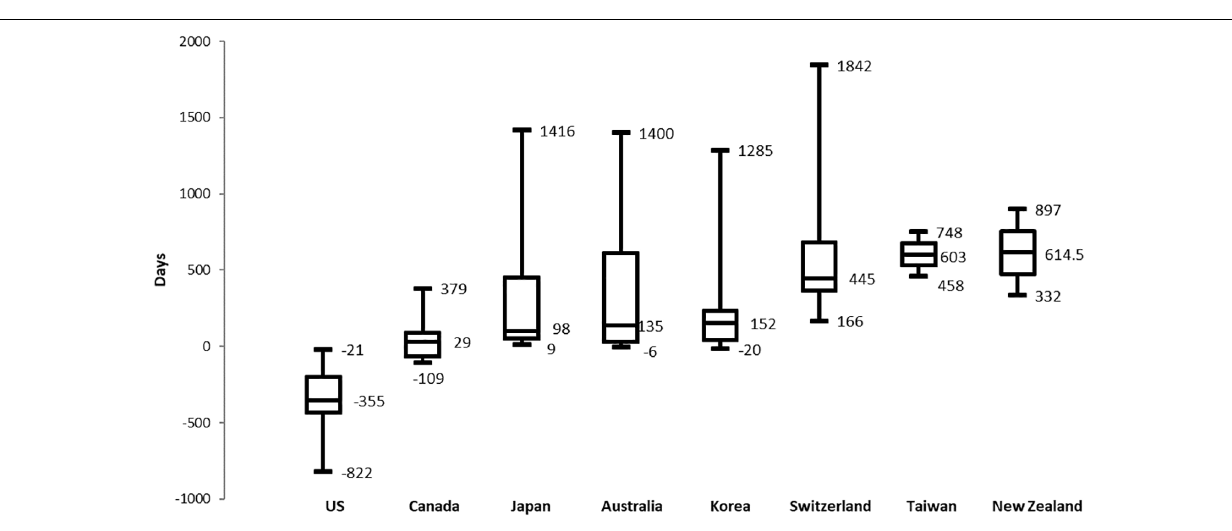
FIGURE 2 | Box-plot of time lag to approval on the basis of EMA (Maximum, Median, Minimum